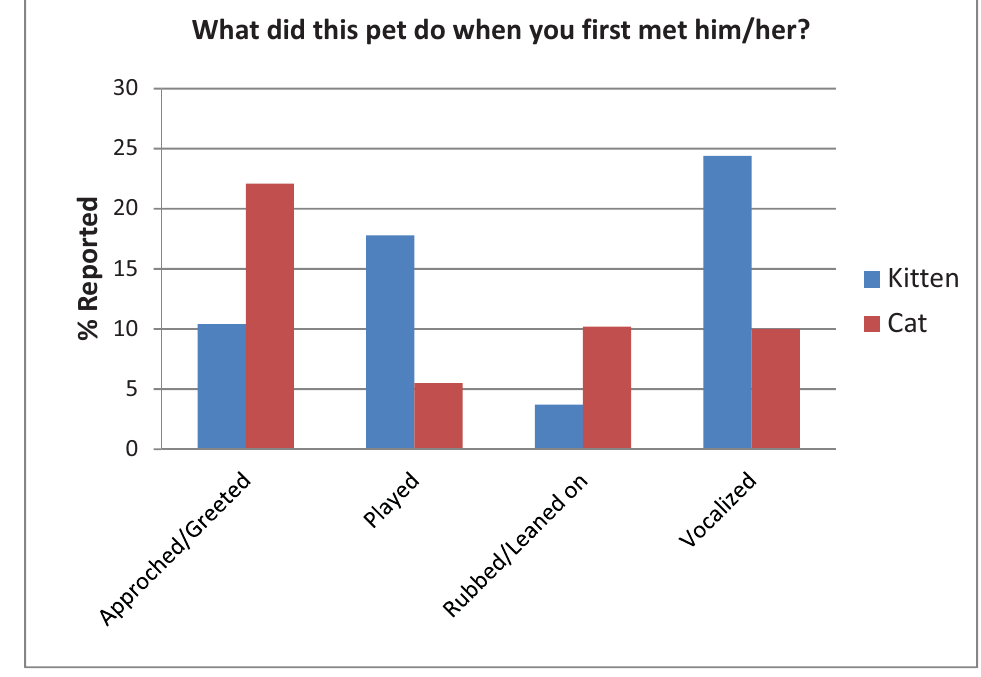
Figure 5. Adopter’s responses when asked the first behavior their kitten or cat exhibited upon meeting them.